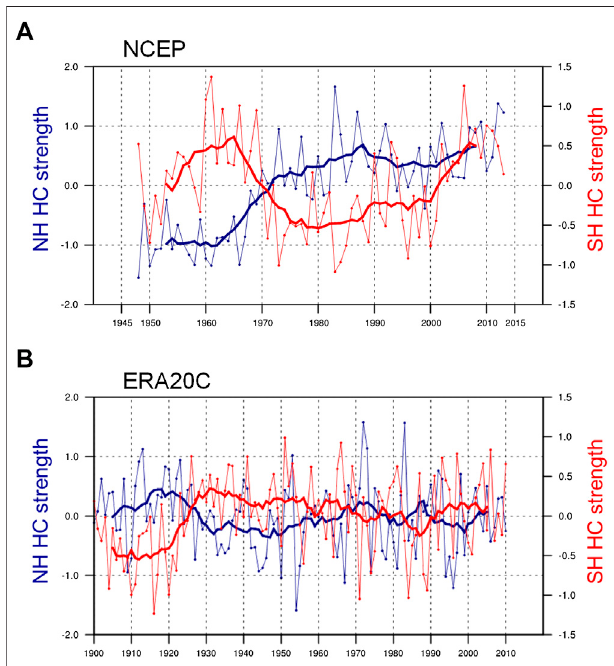
FIGURE 1 | Time series of the raw data (thin lines) and 11-year running averages (decadal component) (thick lines) of the HC strength (10 9 kg s − 1 ) indicesintheNH(bluelines)andSH(redlines)derivedfromthe (A) NCEPdata set for 1948 – 2013 and from the (B) ERA20C data set for 1900 – 2010.